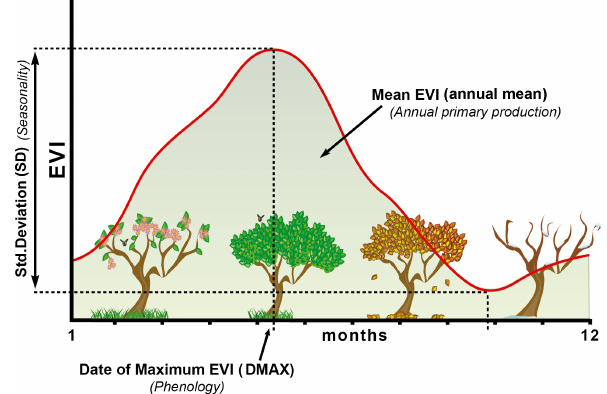
Figure 3. Seasonal dynamics of the EVI and EVI-derived metrics or EFAs. The x axis corresponds to the months of the year and the y axis to the EVI values. EFAs were the annual mean of the EVI, an estimator of annual primary production (EVI_mean), the EVI seasonal coefficient of variation, i.e., a descriptor of season- ality or the differences between the growing and non-growing sea- sons (EVI_sSD), and the date of the maximum EVI, a phenologi- cal indicator of the growing season (EVI_DMAX). We chose these three EVI metrics or EFAs since they capture most of the variance (96.5%) of the EVI seasonal dynamics in a principal component